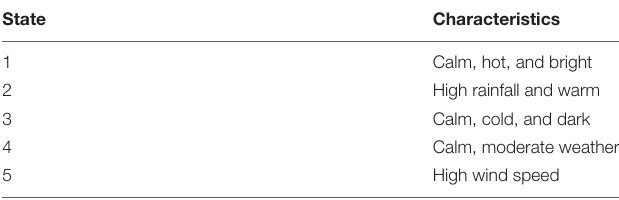
TABLE 3 | Characteristics of the derived state in the example at Wytham.